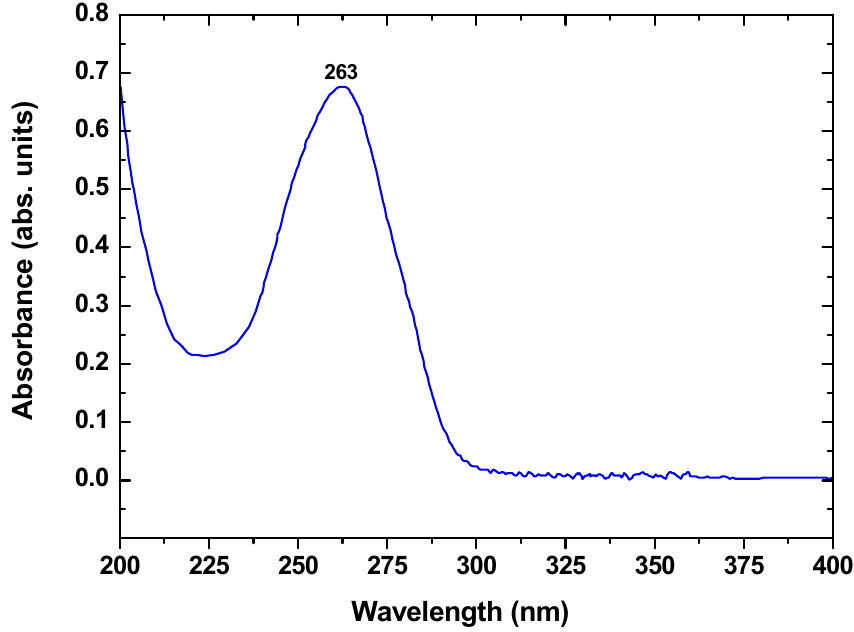
Figure 8. Effect of pH for the removal of PRM from aqueous solutions.